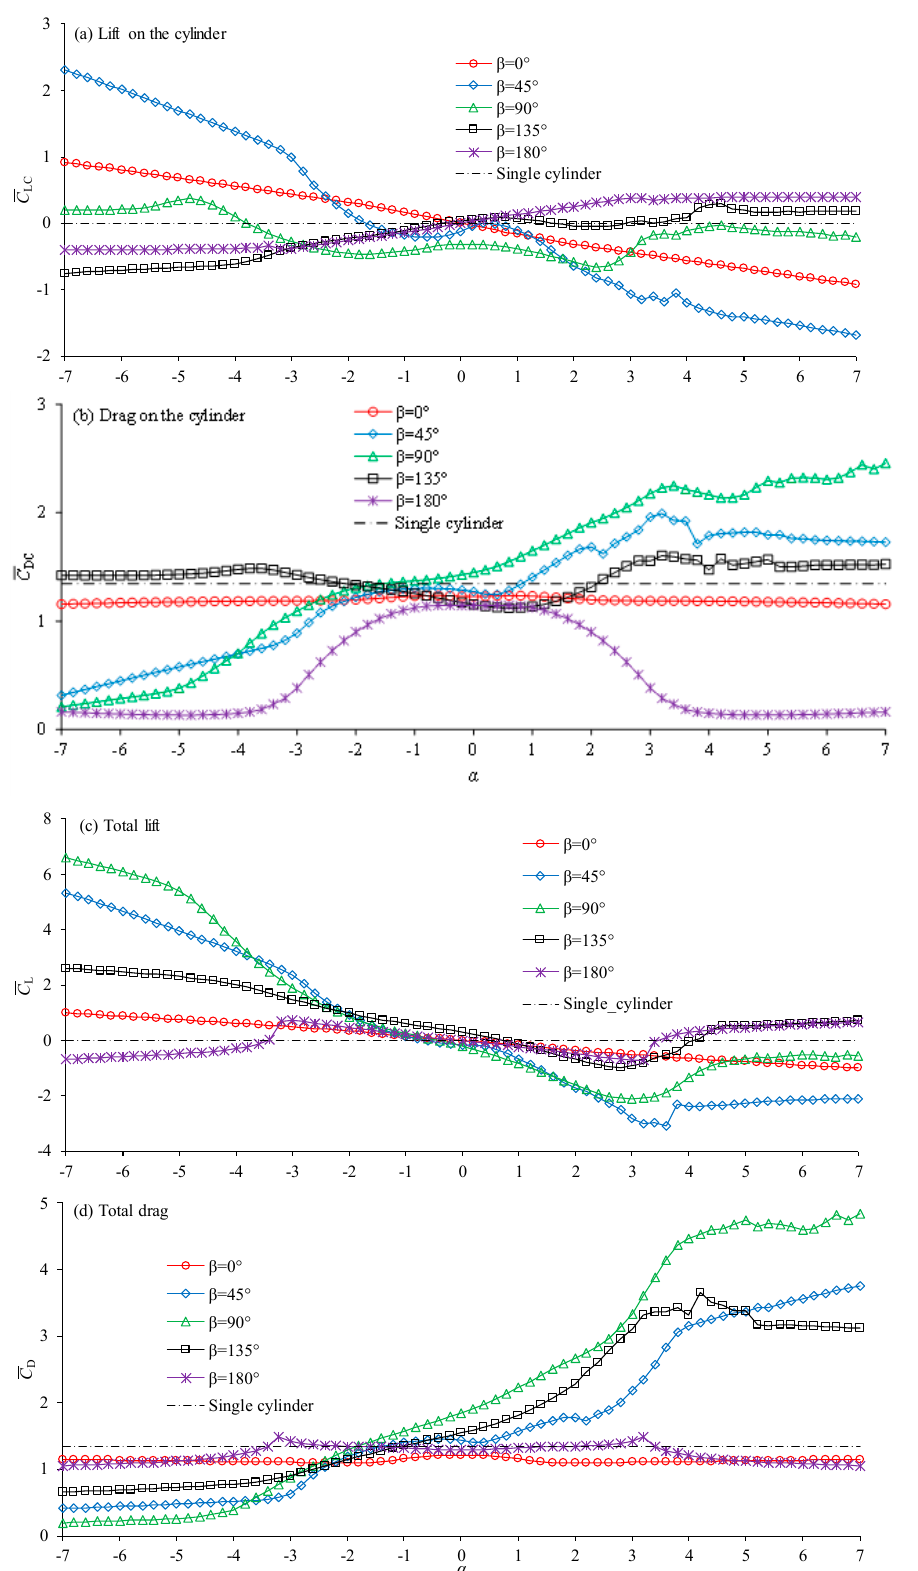
Figure 9. Variation in the mean lift and drag coefficients with rotation rate.